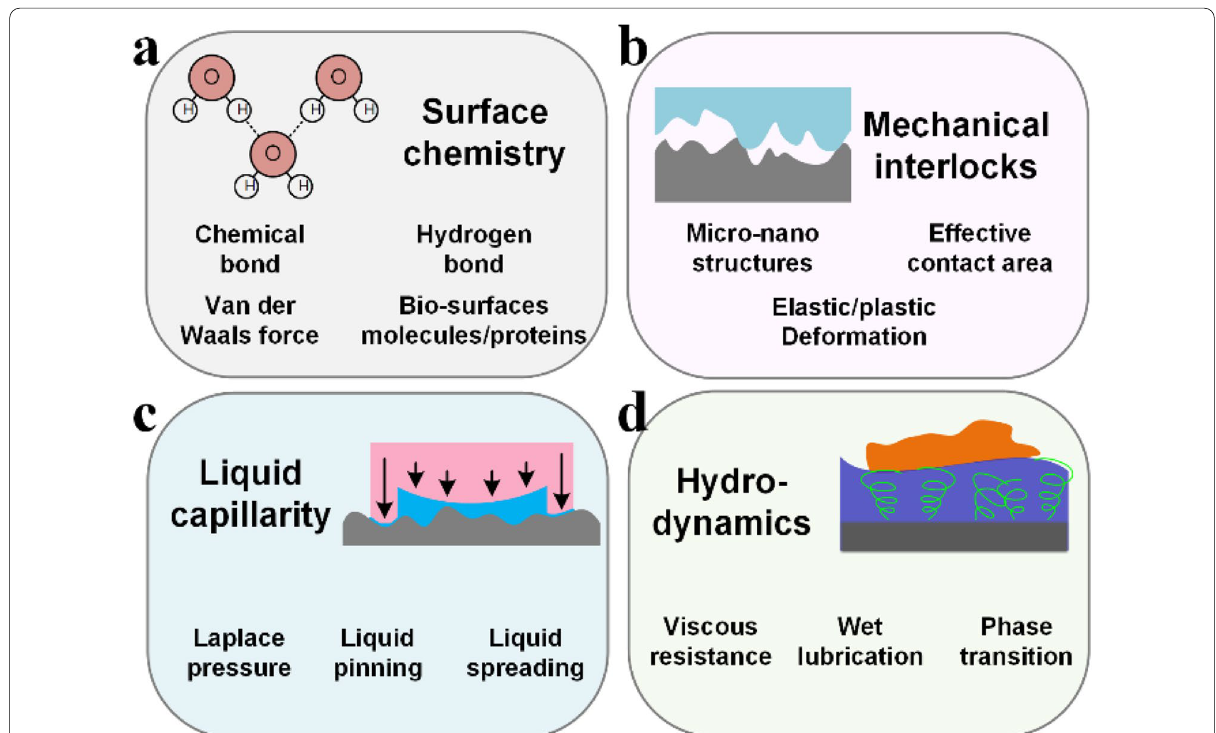
Figure 2 Featured influence factors that affect interfacial contact mechanisms: ( a ) surface chemistry, ( b ) mechanical interlocks, ( c ) liquid capillarity, and ( d )